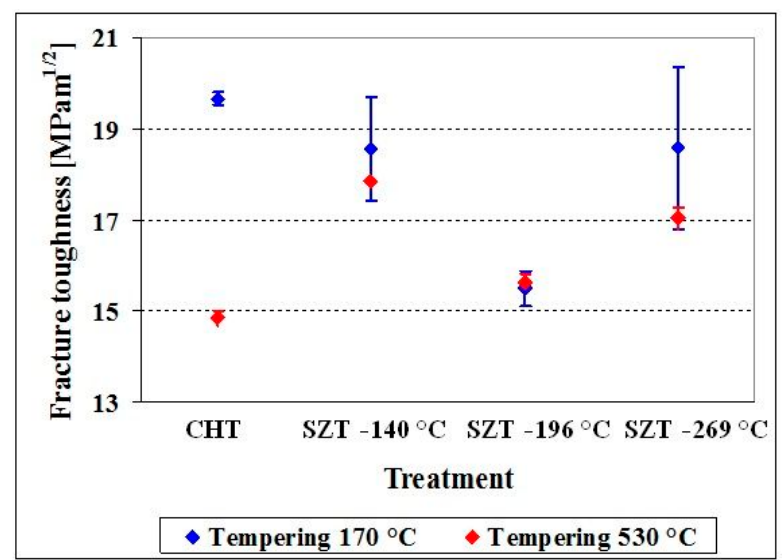
Figure 13. Fracture toughness for differently heat-treated specimens made of Vanadis 6 steel.